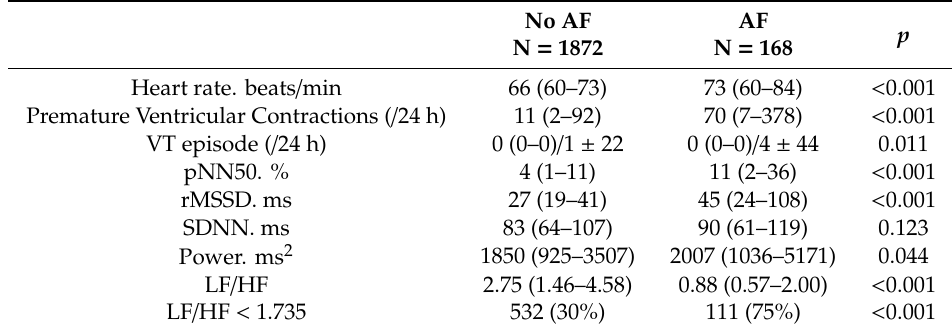
Table 3. Holter parameters according to the onset of new AF during AMI, n (%), median (interquartile range) or mean ( ± standard deviation).